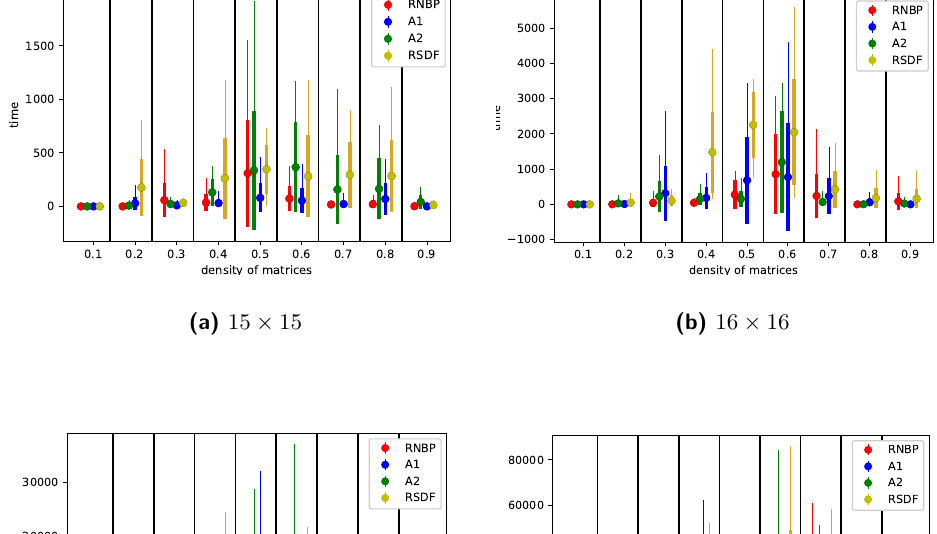
0.1 0.2 0.3 0.4 0.5 0.6 0.7 0.8 0.9 density